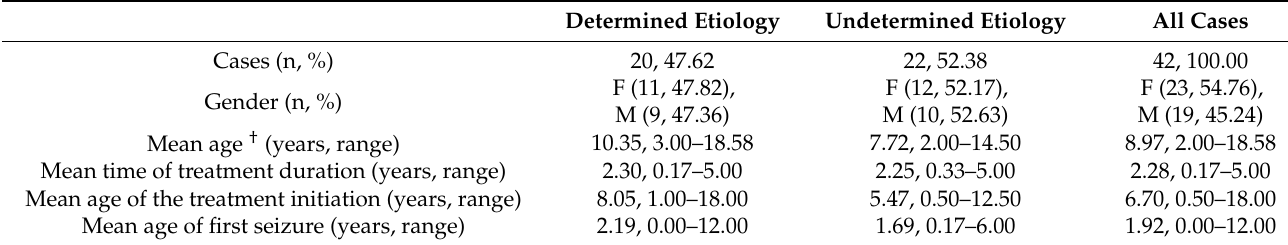
Table 1. General characteristic of the cohort. Determined Etiology Undetermined Etiology All